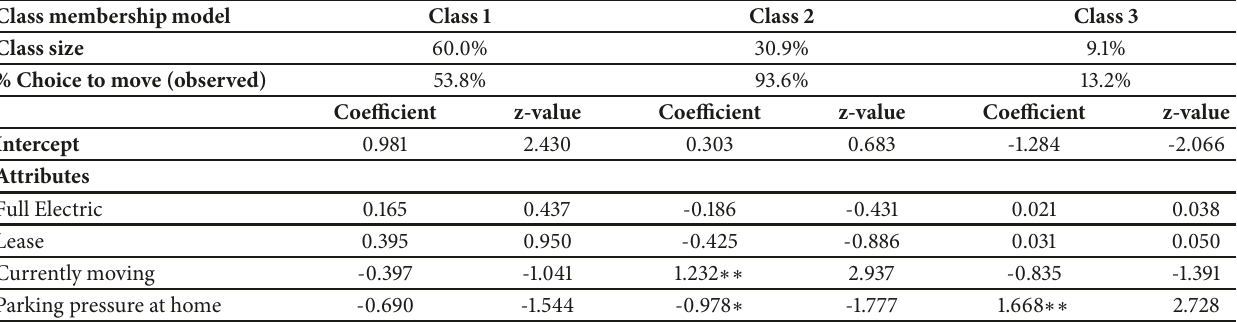
Table 7: Class membership model for 3-class